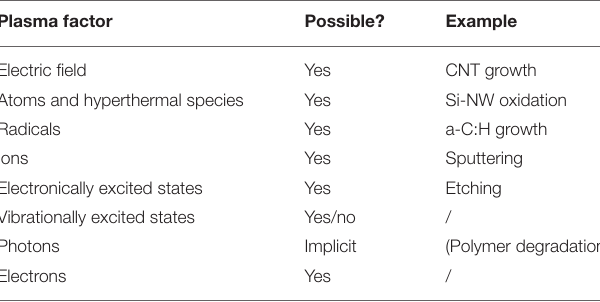
Frontiers in Physics |